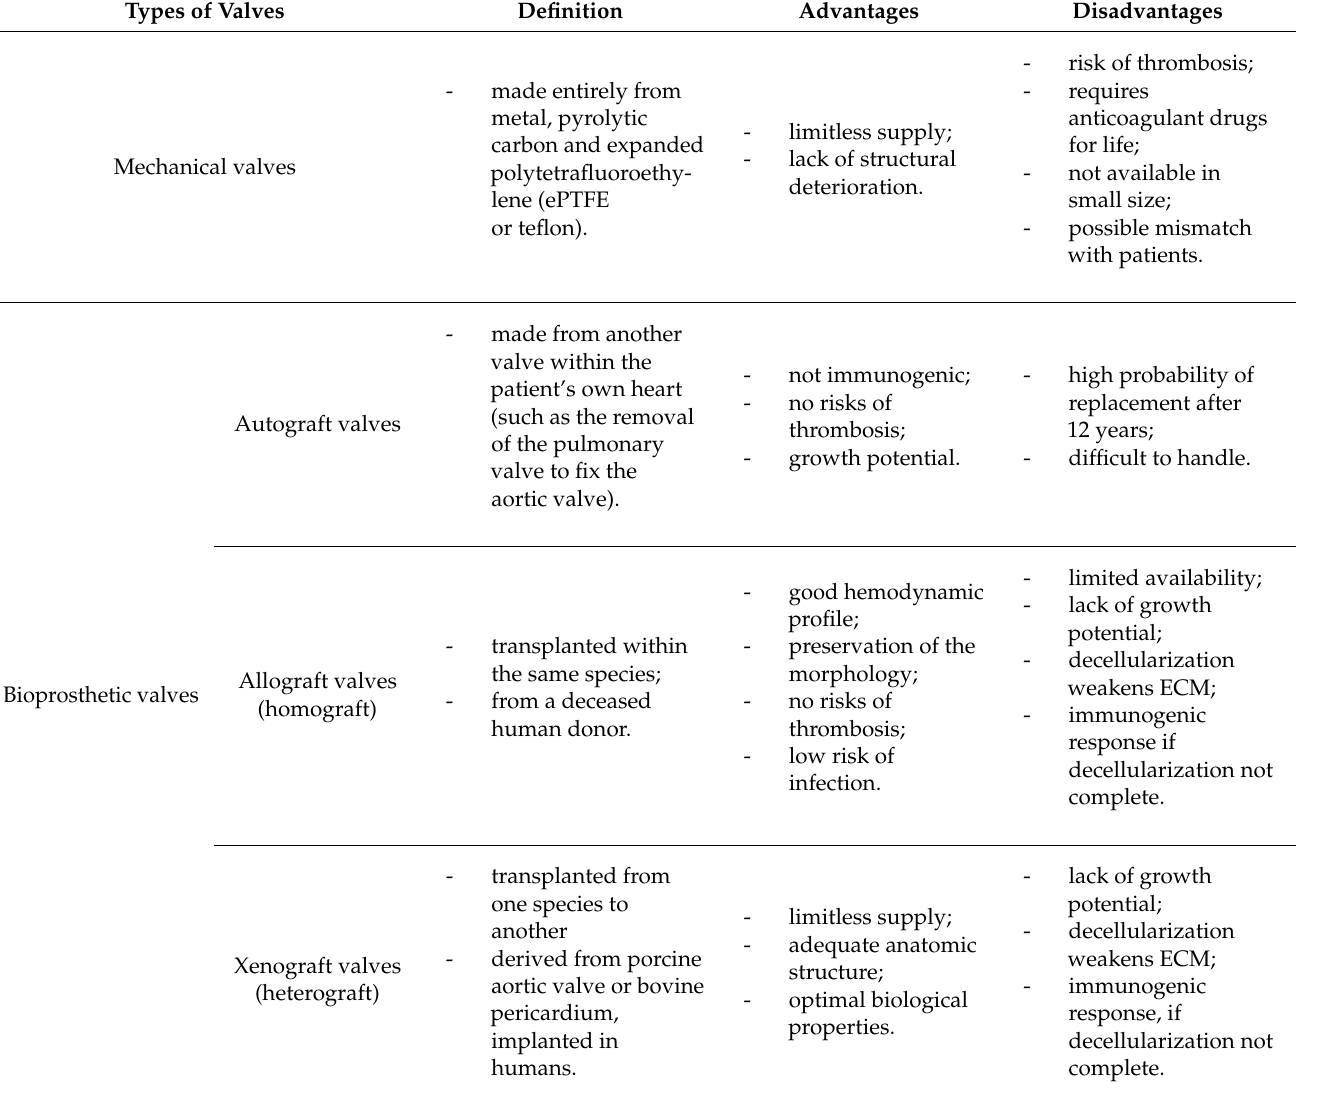
Table 2. The classification and the advantages/disadvantages of heart valve